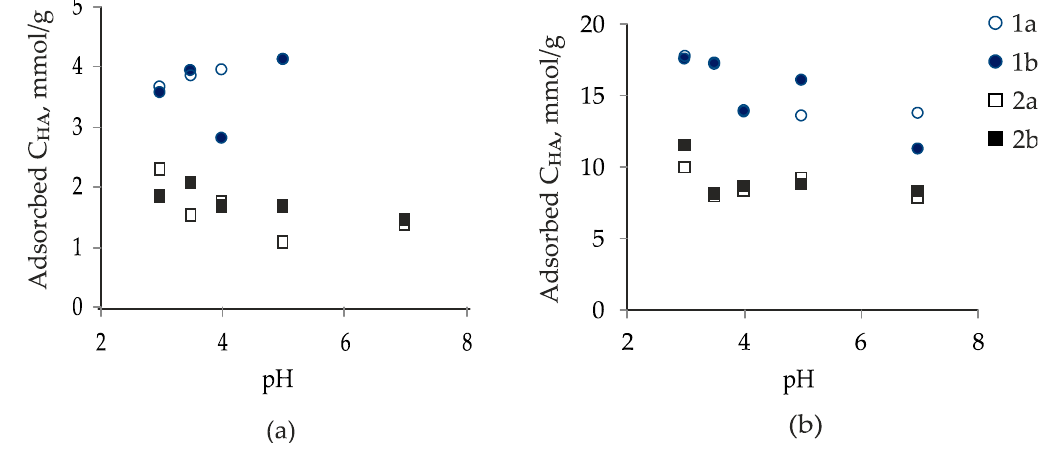
Figure 7. The dependence of the adsorbed HA amount from HA solutions with concentrations of 6.09 mmol/L ( a ) and 24.35 mmol/L ( b ) on pH values. I = 0.1 mol/L. 1 , 2 = Na- and Al 13 -bentonite , respectively. Empty and filled icons—repetitions of an experiment.